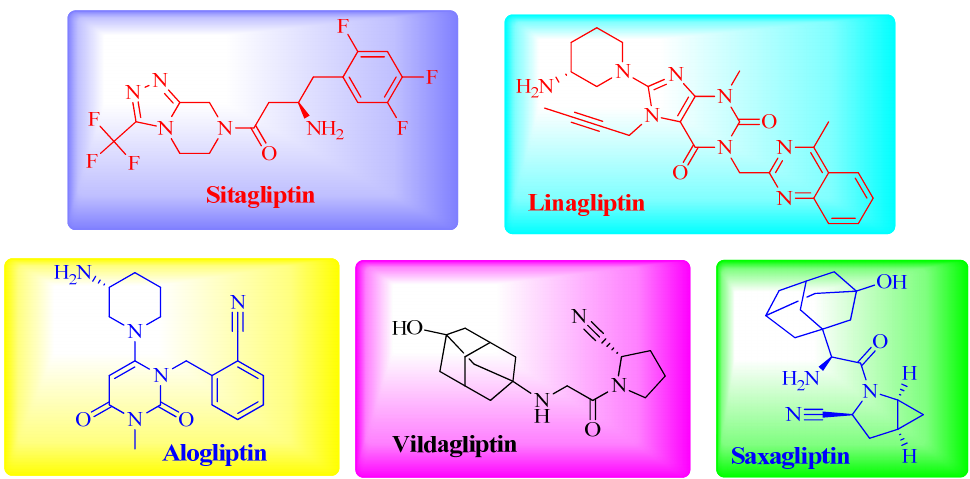
Figure 1. Structures of clinically-approved DPP-IV inhibitors.